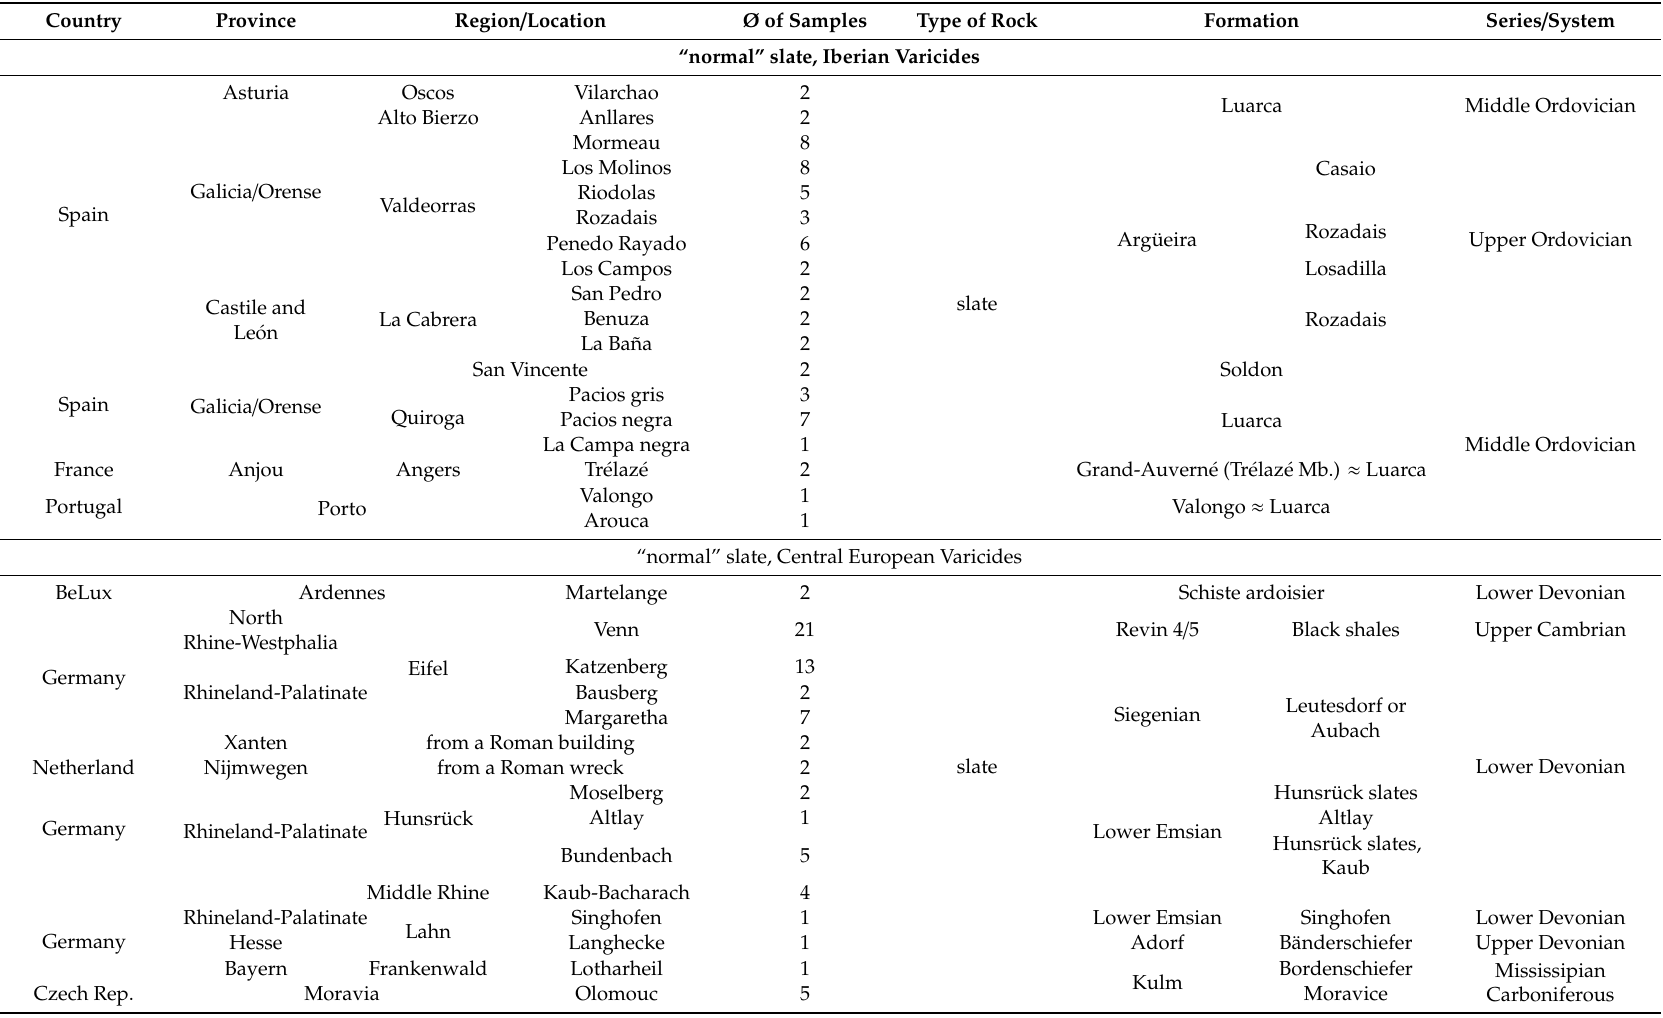
Table 1. The geological information of the slate samples analyzed in this paper (also based on [4,6,9,12,14,15,18,24].